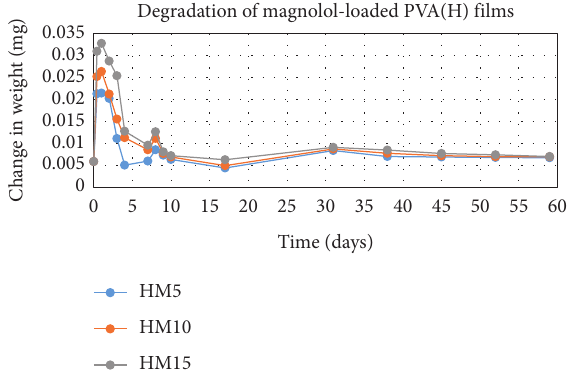
Figure 5: Degradation of magnolol-loaded PVA (H) films.